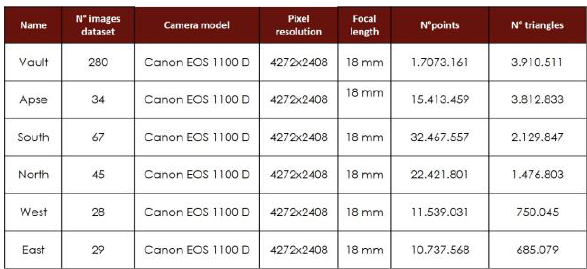
Figure 11. Information regarding datasets acquisition